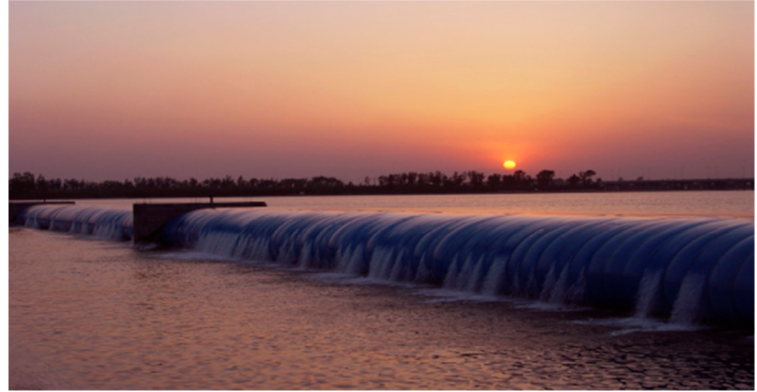
Figure 13. The landscape at Rubber Dam